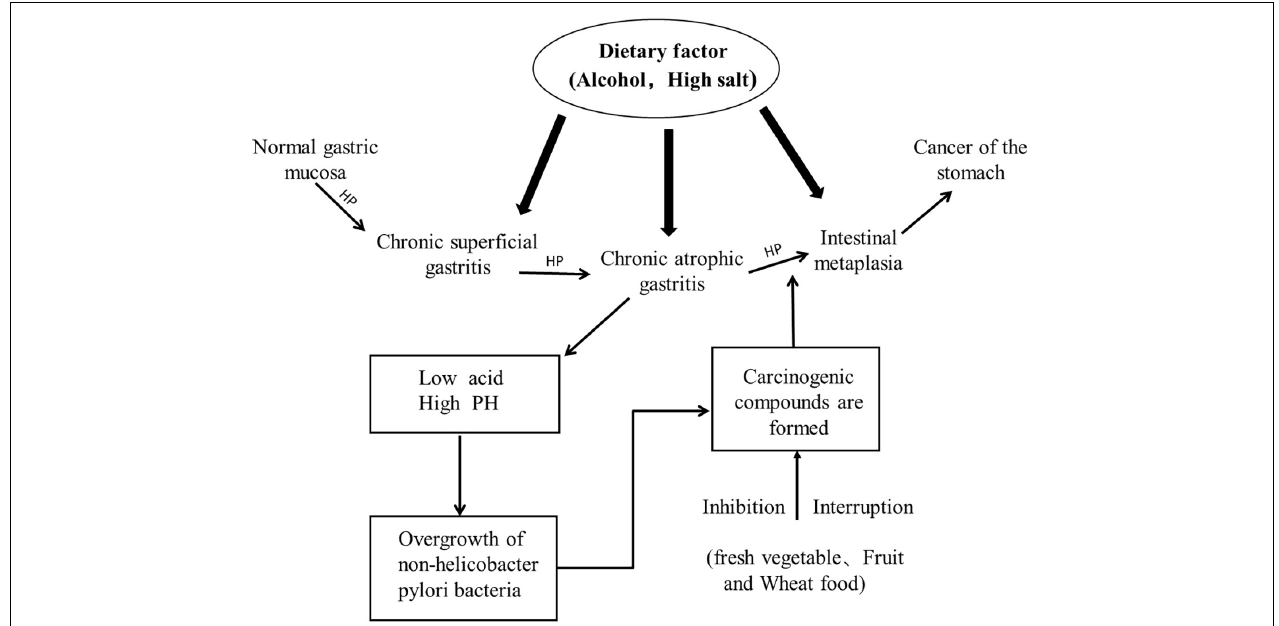
FIGURE 1 | Carcinogenesis pattern of intestinal type gastric